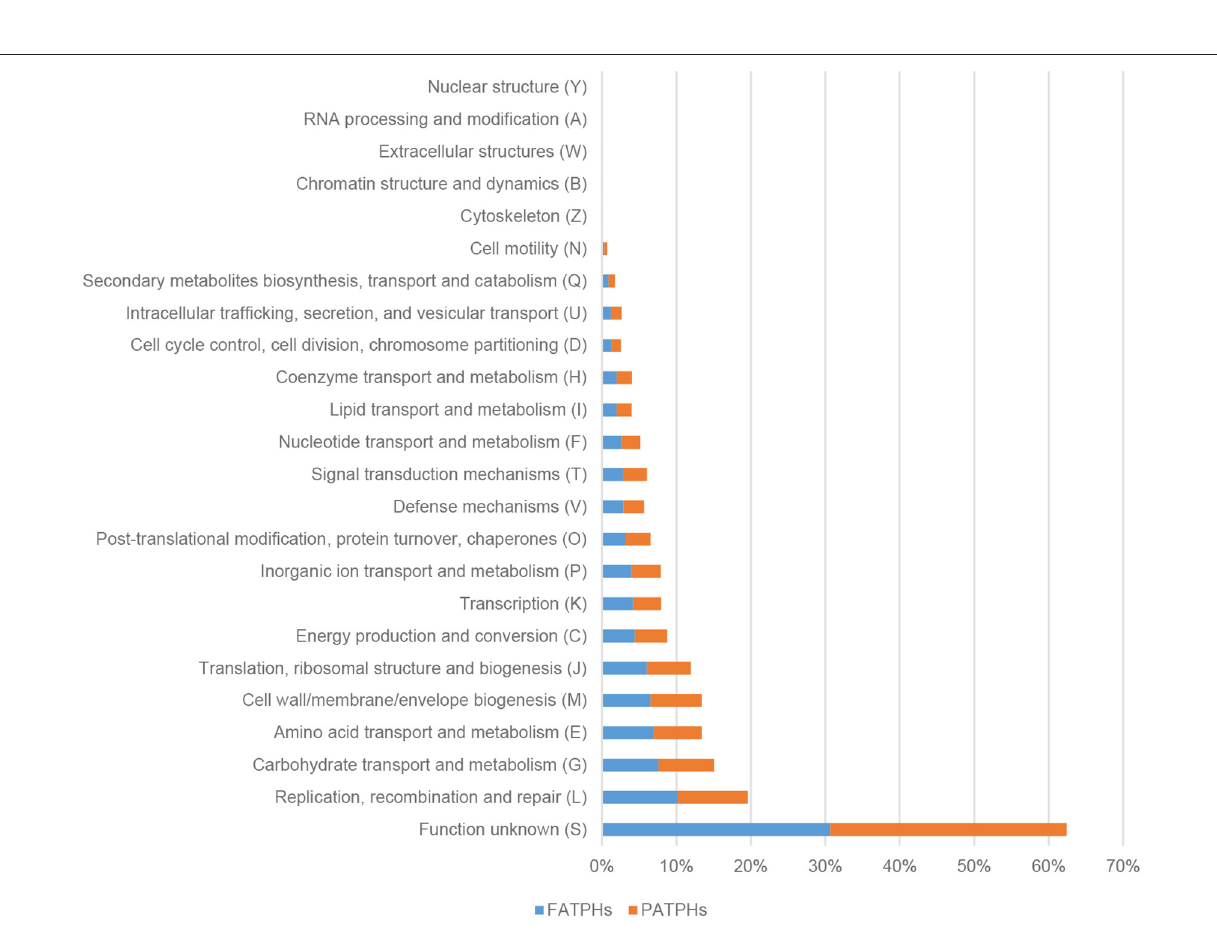
FIGURE 9 | Distribution of COG functions in FATPHs and PATPHs. E ≤ 1e −